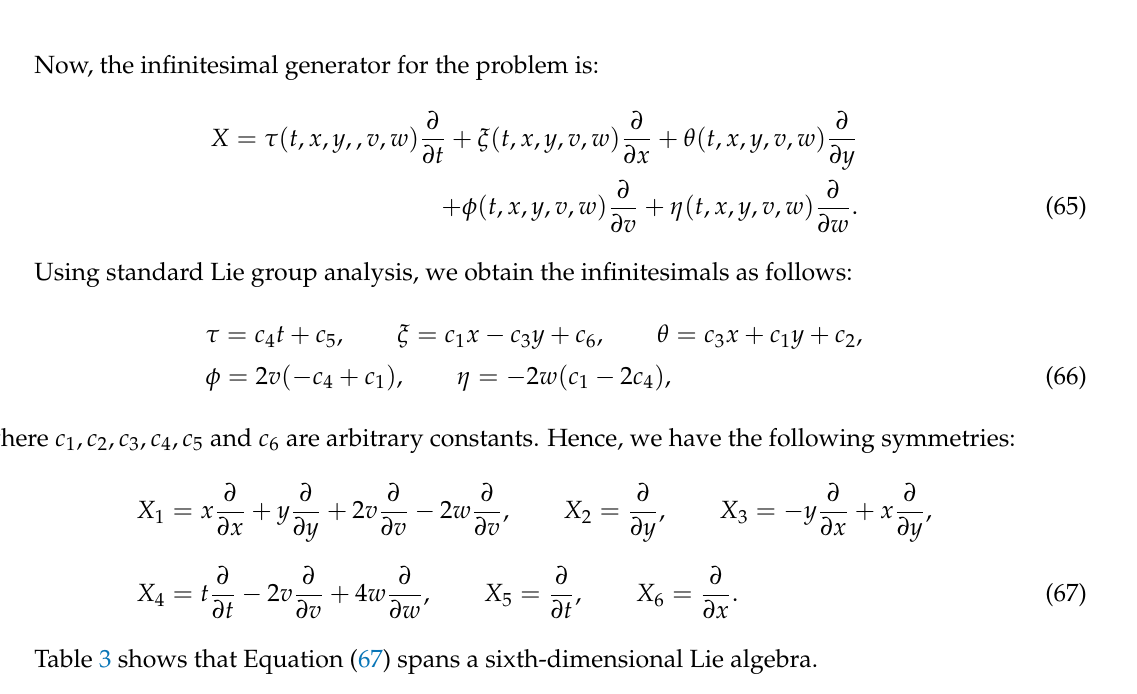
Table 3. Commutators span six-dimensional Lie